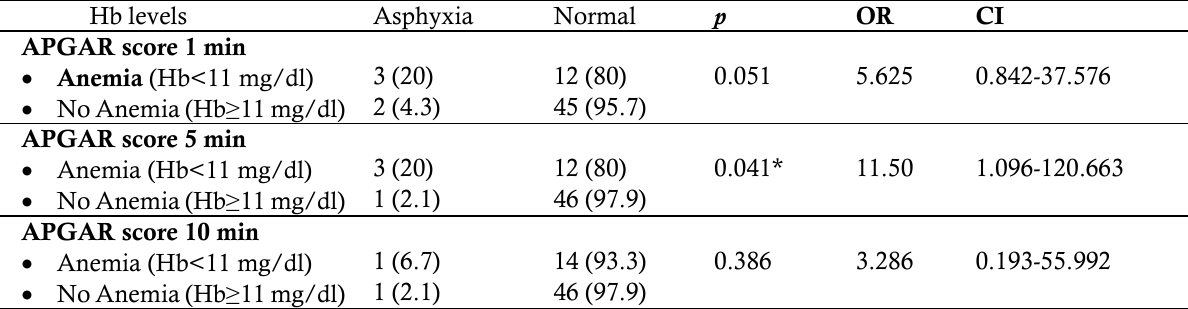
Table 2. Correlation of Hb levels and 1, 5 and 10 min APGAR score in placenta previa